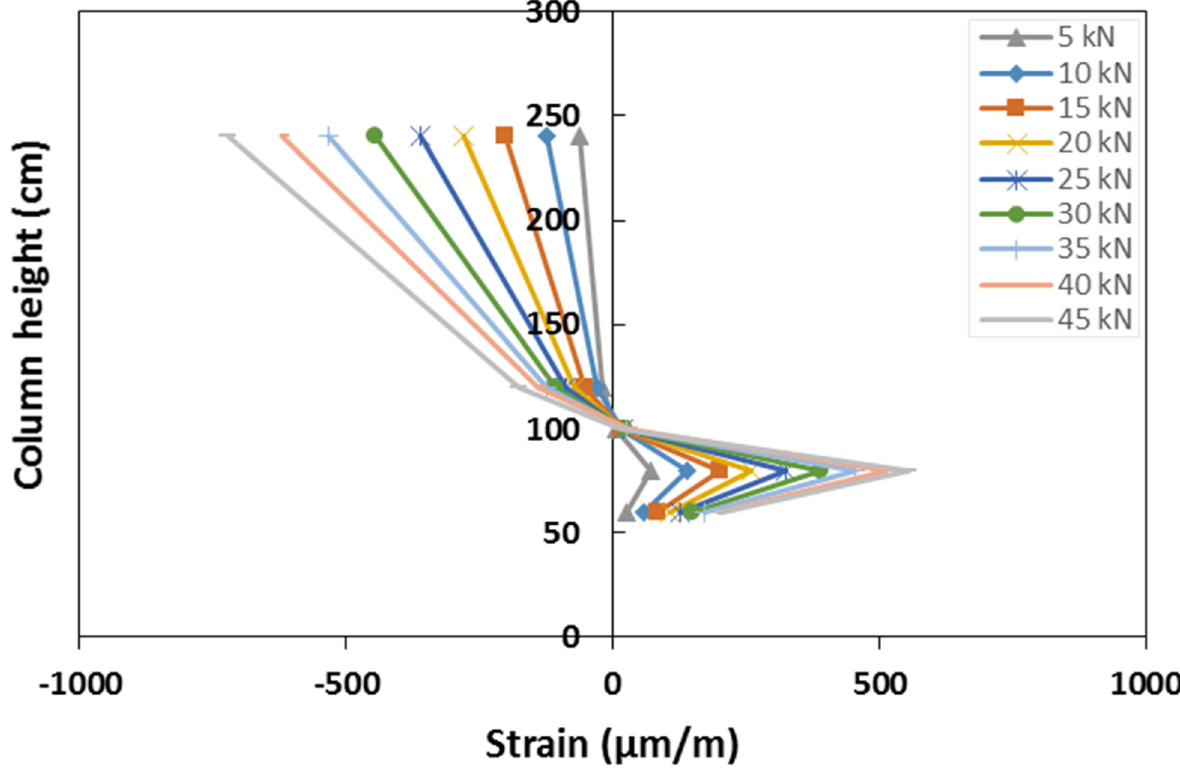
Figure 19. Strain distribution along the external flange of the column.